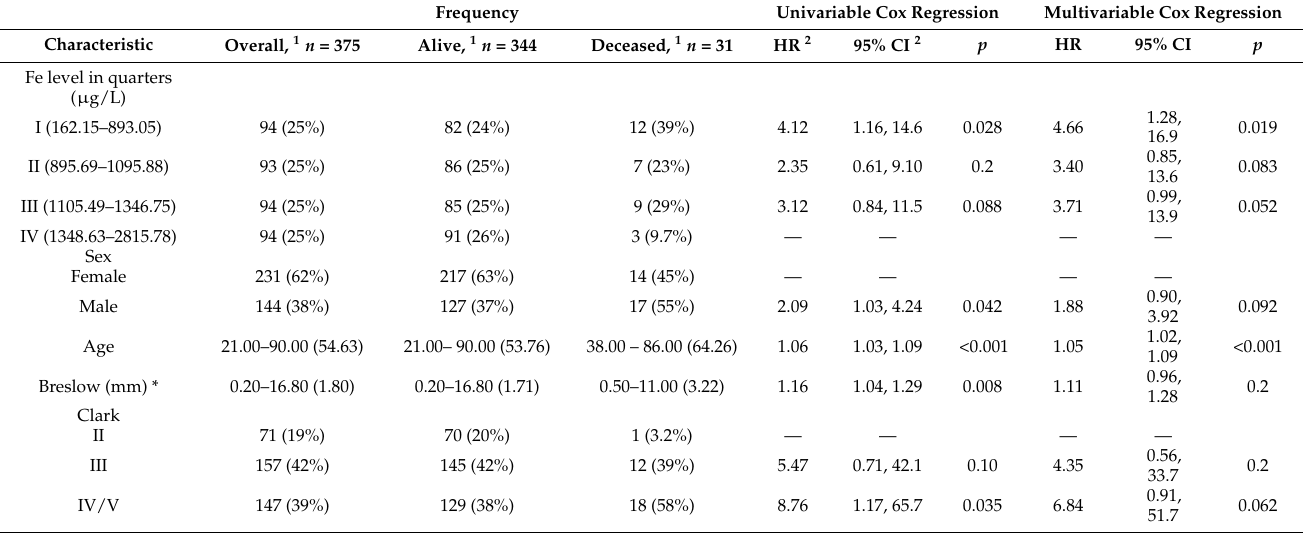
Table 1. Characteristics of the study group and uni- and multivariable Cox proportional hazard models for given factors ( n =